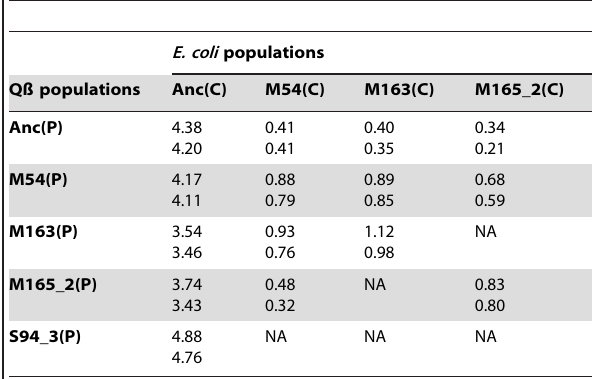
Table 2. Fitness of ancestral and evolved Q b